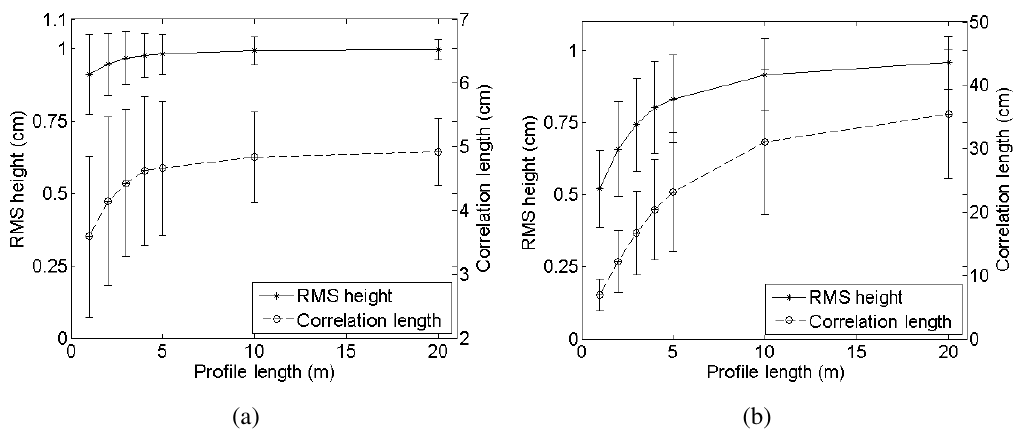
Figure 6. Mean and standard deviations of RMS height and correlation length for differ- ent profile lengths, sampled from large profiles with (a) ( s , l ) = (1 cm,5 cm) and (b) ( s , l ) = (1 cm,40